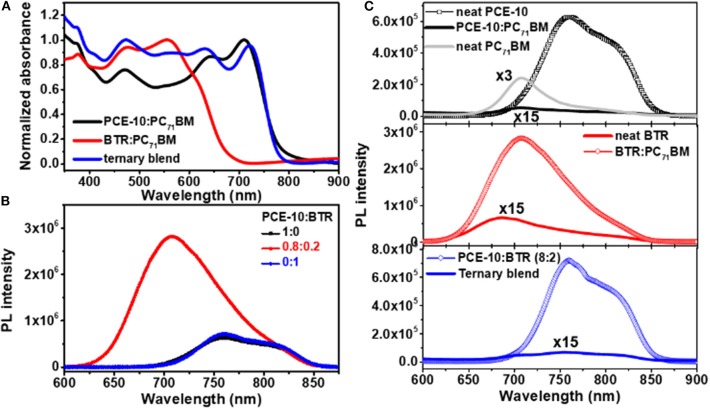
(A) Normalized absorption spectroscopy of binary and ternary blend films. (B) Photoluminescence (PL) quenching based on neat donor(s) and binary (ternary) blend films. (C) PL spectroscopy of neat and co-blended donor films.